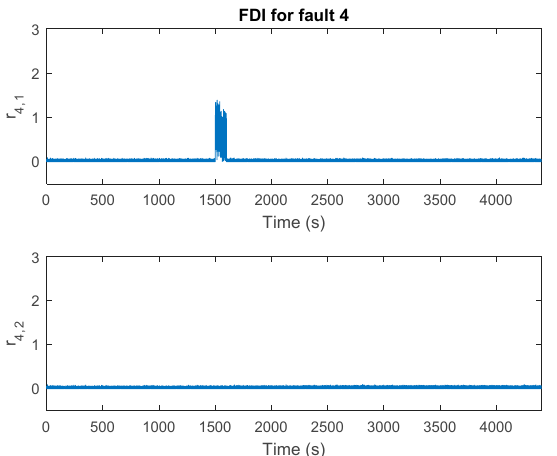
Figure 8. The abrupt fault of rotor speed sensor 1 in the time period of 1500 to 1600 s.